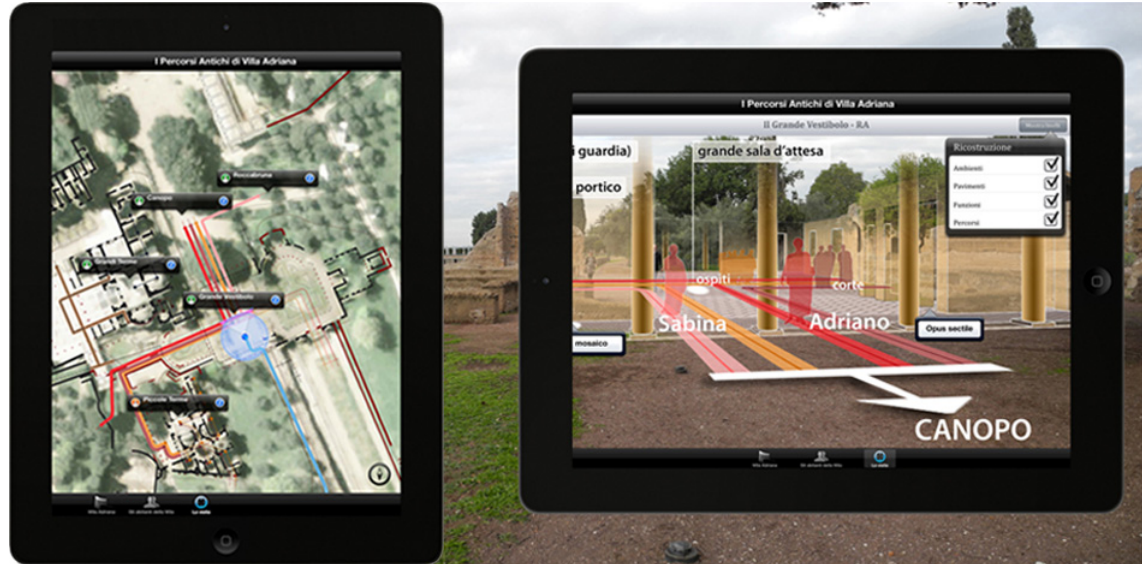
Figure 7. App Contents. Figure 8. Augmented